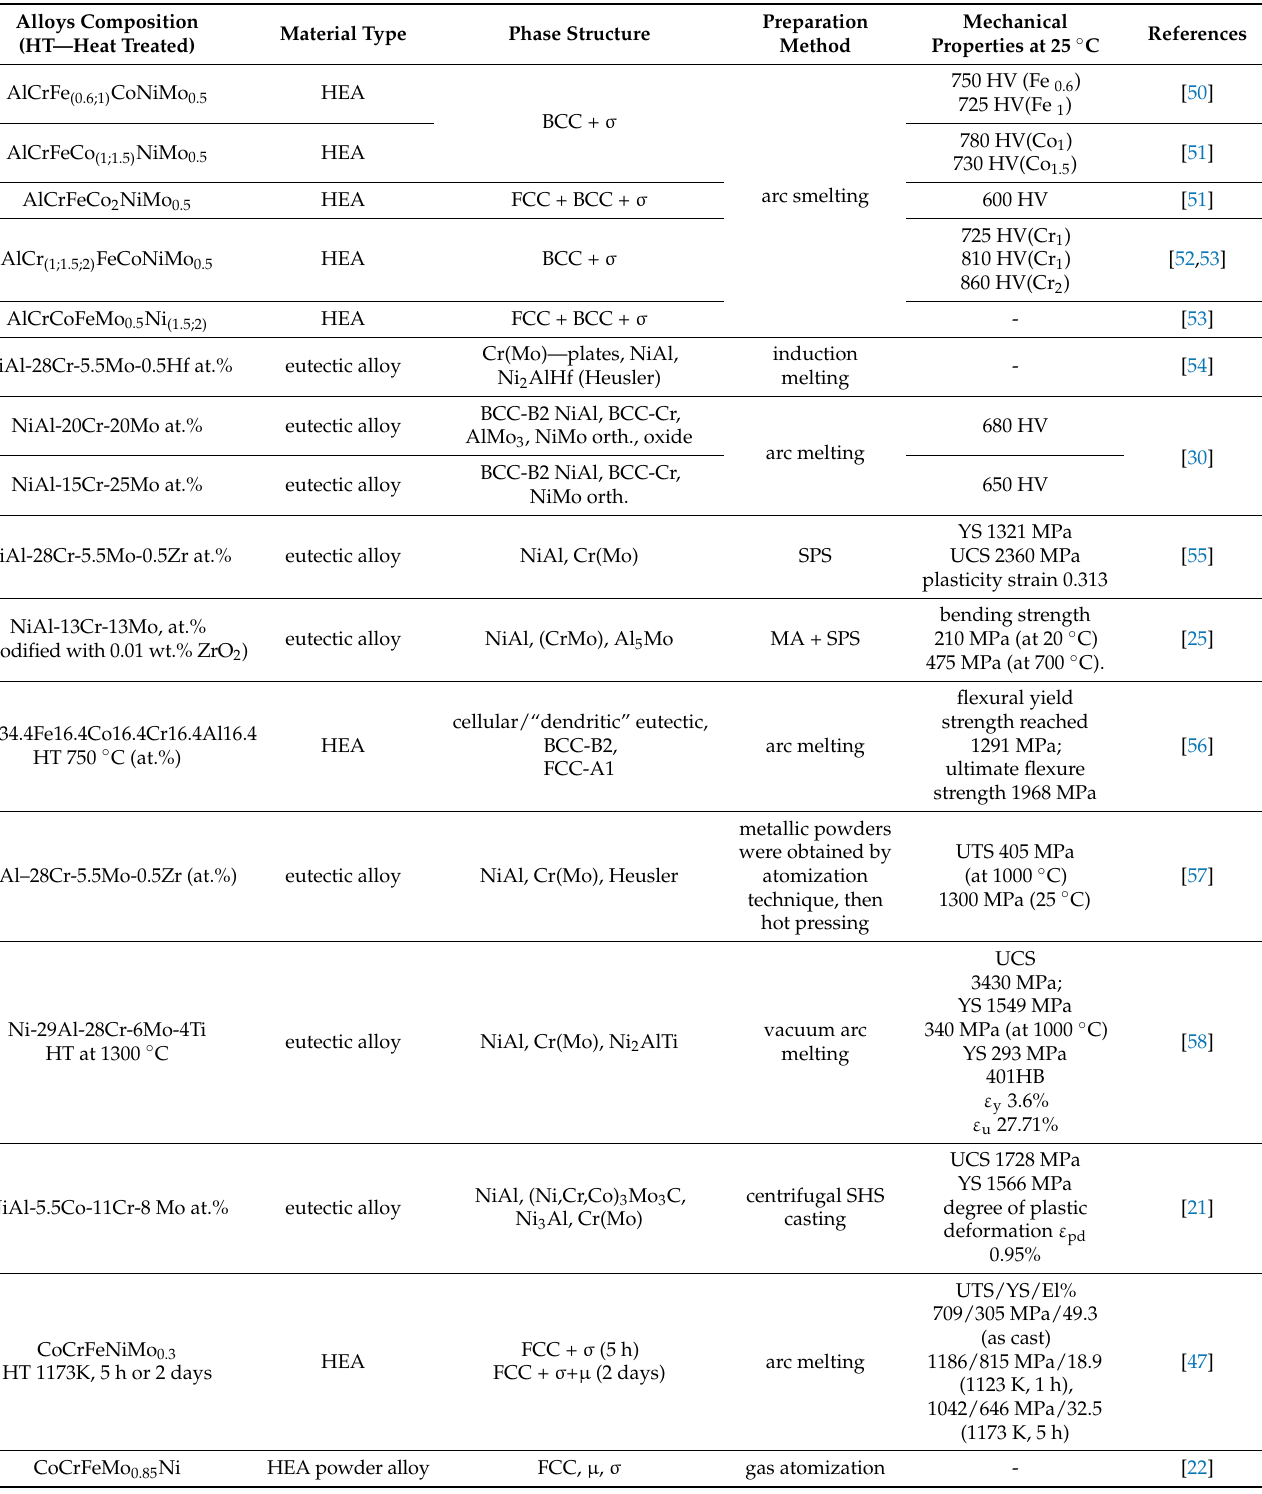
Table 1. Alloys based on transition metals, composition and